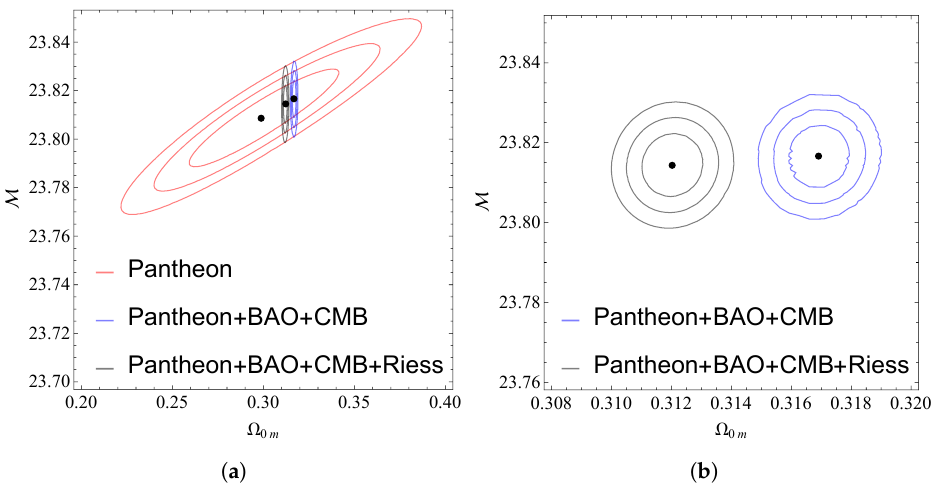
Figure 20. Confidence contours for the Λ CDM model with the addition of the Riess point: ( a ) The 1 σ − 3 σ confidence contour in the parametric space ( M − Ω 0 m ) for SNIa data, SNIa+BAO+CMB and SNIa+BAO+CMB+Riess data. ( b ) The 1 σ − 3 σ confidence contour in the parametric space ( M − Ω ) for the SNIa+BAO+CMB and SNIa+BAO+CMB+Riess data. 0 m